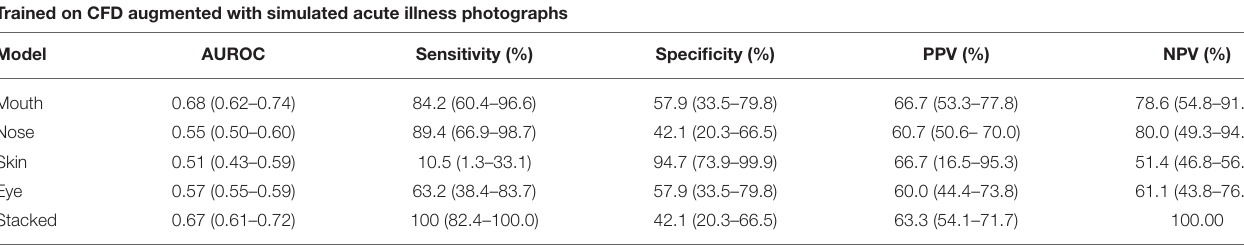
TABLE 1 | Performance of the best models for each feature and the stacked model on the validation set. Trained on CFD augmented with simulated acute illness photographs